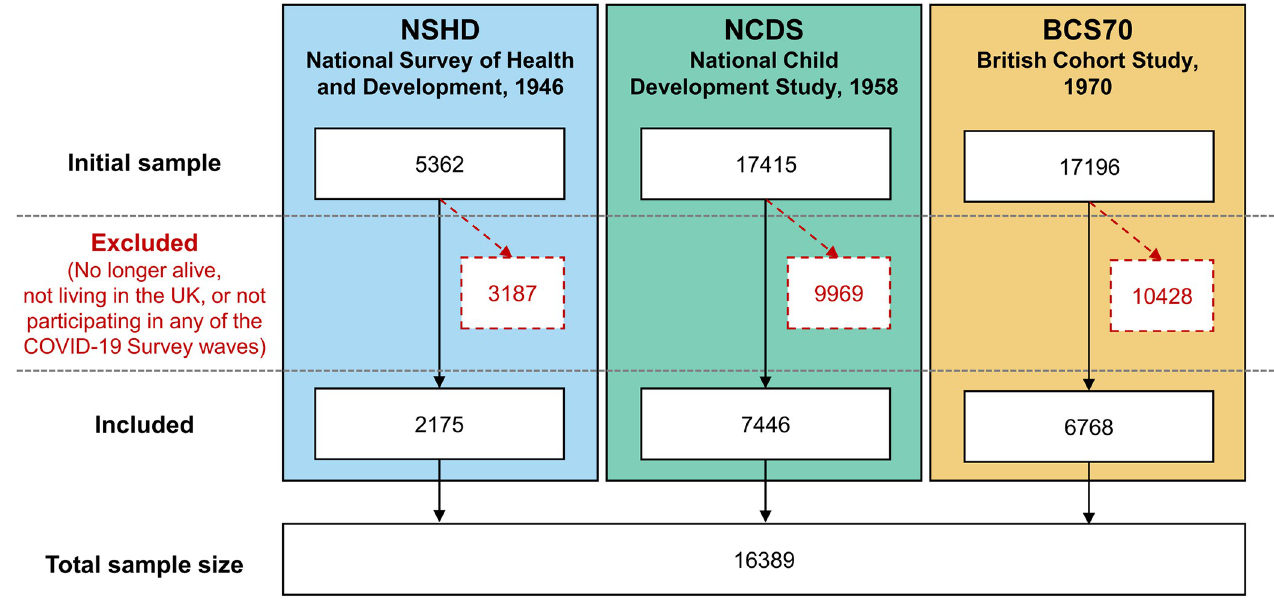
Fig 1. Sample flow